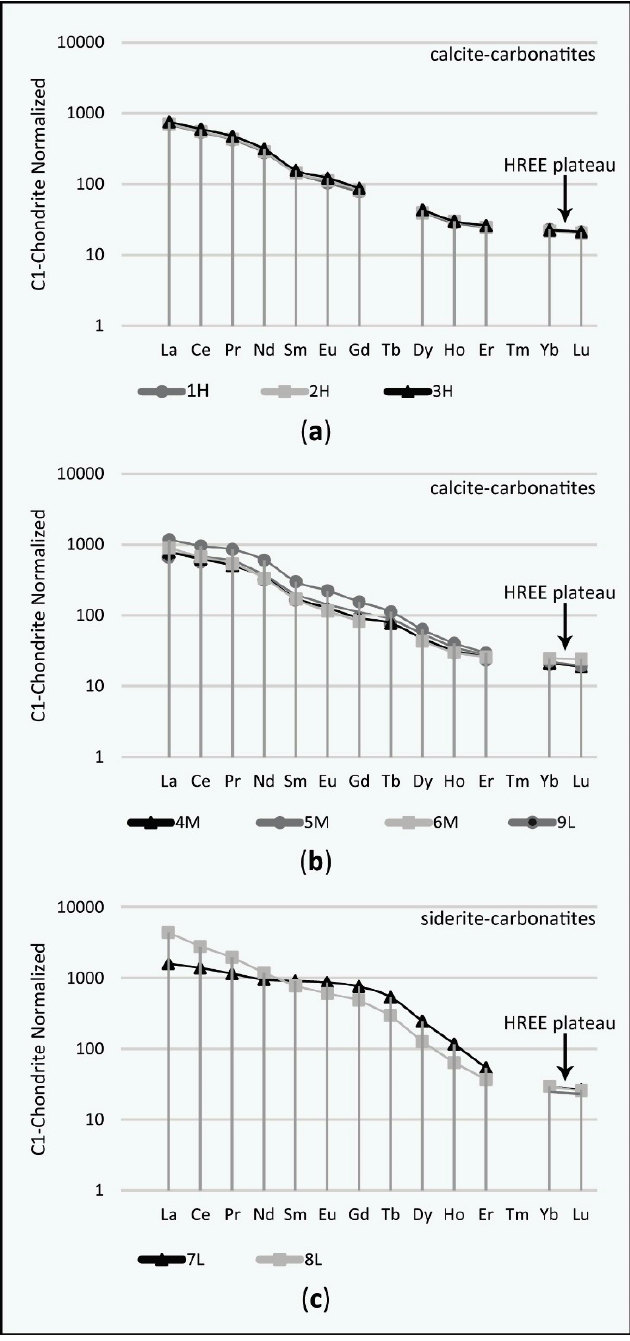
Figure 7. REE distribution patterns of nine collected field samples. The values are normalized to C1-chondrite [36]. Graph ( a ) shows the REE distribution patterns of samples 1H, 2H and 3H that were expected for the søvite outcrop, as published by [39]; Graph ( b ) shows four REE distributions of samples 4M, 5M, 6M, and 9L that mainly belong to the calcite-carbonatite rocks shown in graph (a). Sample 5M shows a slightly higher enrichment of light REE (LREE (n) ) and middle REE (MREE (n) ), but with the same distribution patterns as those for the samples in graph (a); Graph ( c ) shows different distributions that represent siderite-bearing carbonatites (7L and 8L) and indicates higher LREE (n) and MREE (n) concentrations. However, the MREE (n) indicates a positive anomaly. The curves plateau towards the heavy REEs (HREE (n) ) in all three